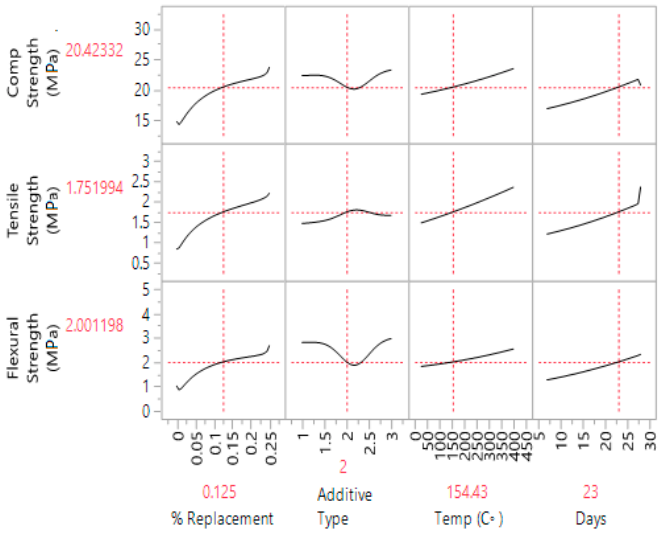
Figure 8. Prediction profiler for compression, tensile and flexural strength with respect to features.